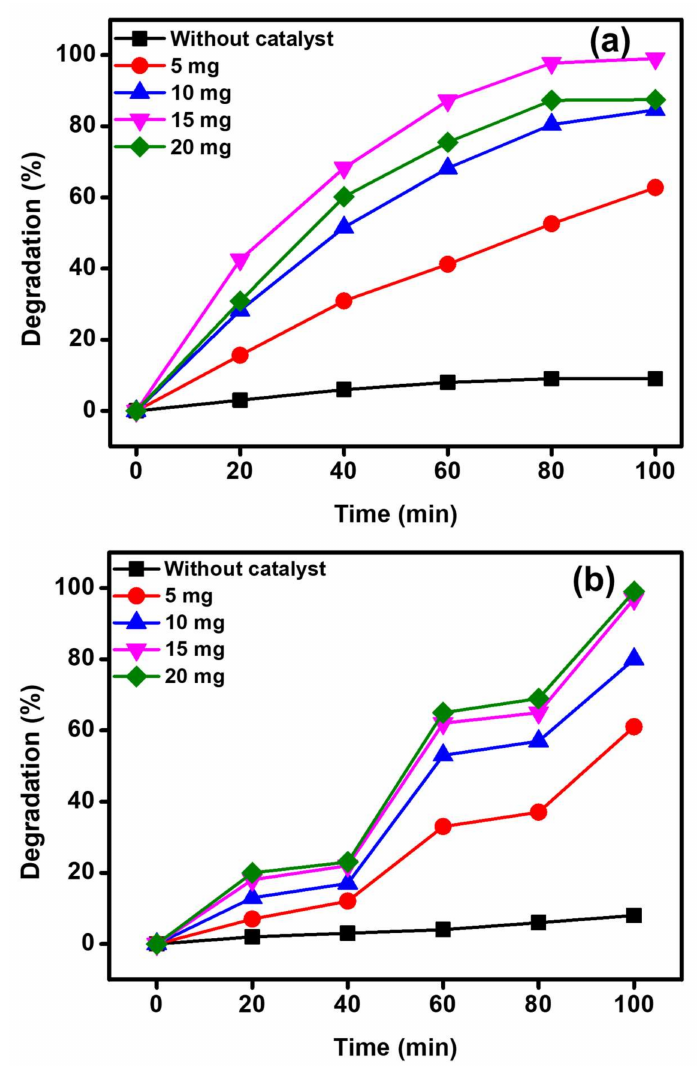
Figure 8. Impact of photocatalyst dose on ( a ) MB and ( b ) MY photodegradation employing the as-synthesized ZnO